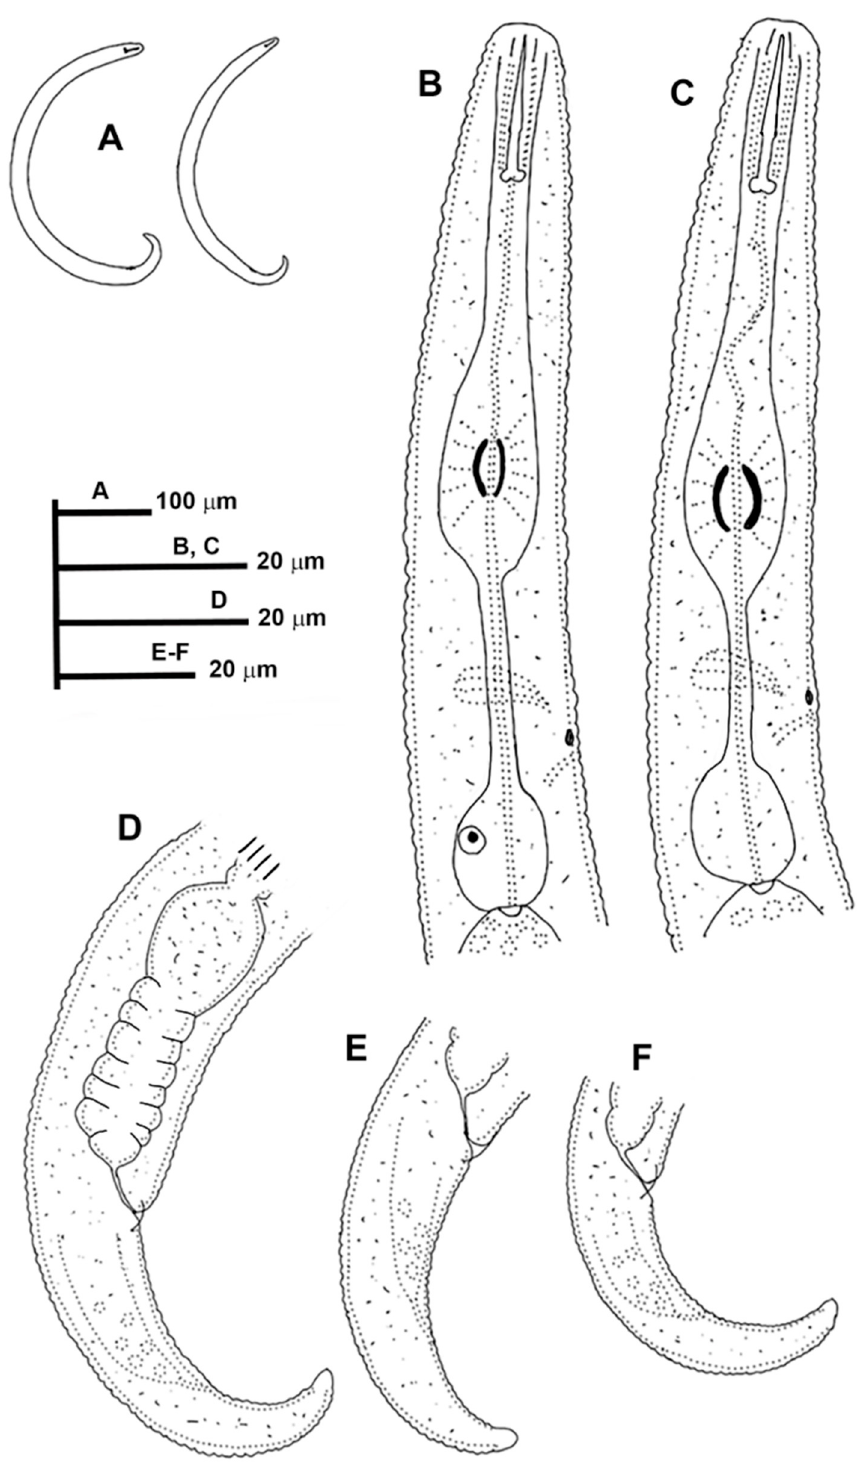
Figure 9. Line drawings of Paratylenchus zurgenerus sp. nov. ( A ): Entire females; ( B , C ): Female pharyngeal region; ( D – F ): Female posterior region.